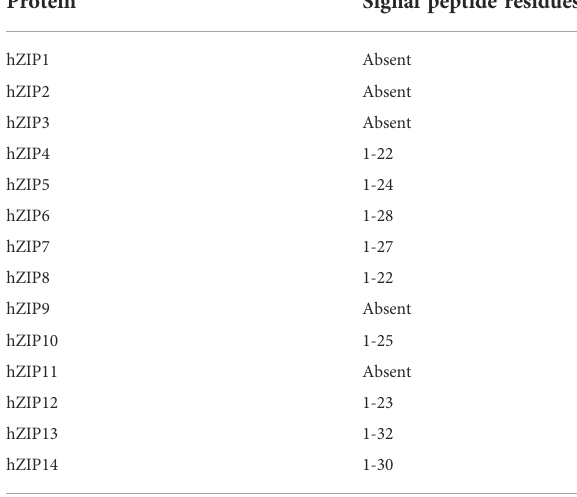
TABLE 1 Predicted signal peptide for each